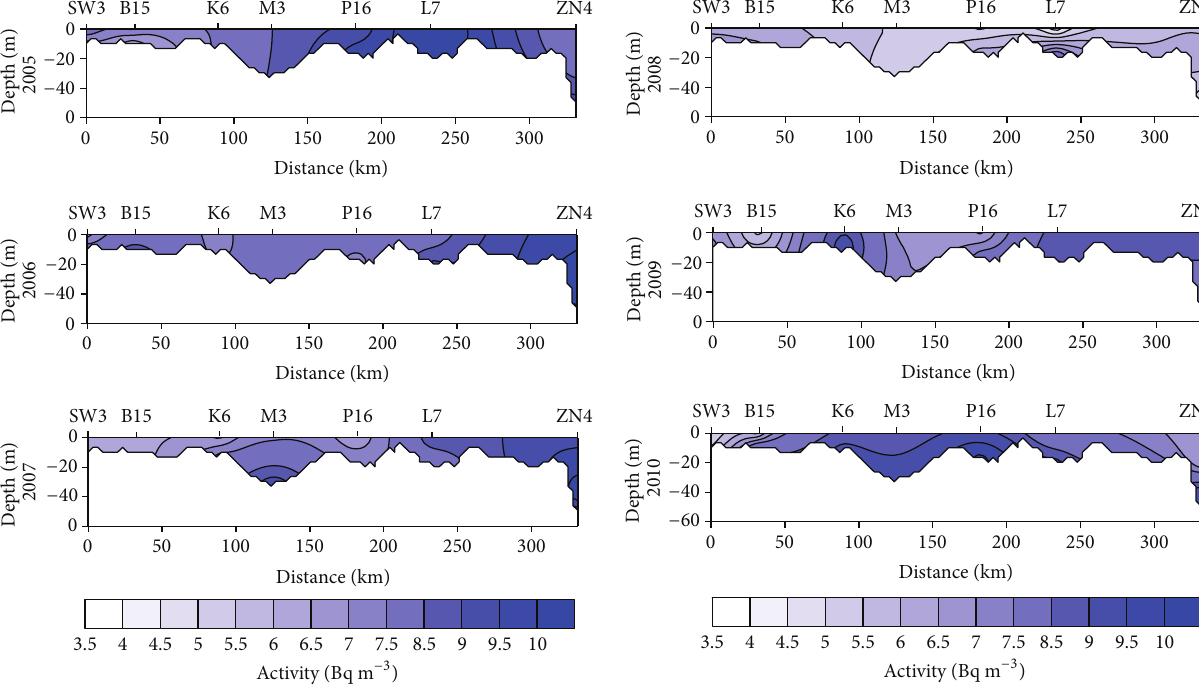
Figure 6: Seasonal and spatial variations in 90 Sr activity in the coastal profile in the years